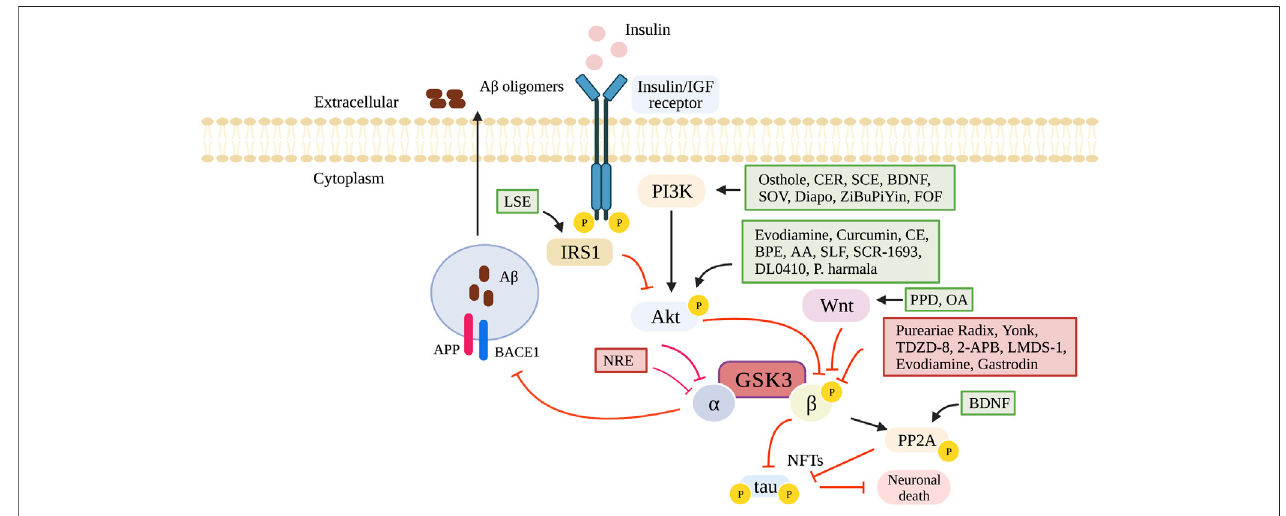
FIGURE 2 | GSK3 pathway and its modulating compounds. 2-APB, 2-Aminoethoxydiphenyl borate; AA, Asiatic acid; Akt, Protein kinase-B (serine/threonine kinase); APP, amyloid precursor protein; BACE1, beta-site APP cleaving enzyme 1; BDNF, brain-derived neurotrophic factor; BPE, bee pollen extract; CE, cinnamon extract; CER, sea cucumber cerebrosides; Diapo, diapocynin; FOF, fl avonoids of okra fruit; GSK3, glycogen synthase kinase-3; Insulin/IGF receptor, insulin-like growth factor 1 receptor; IRS1, insulin receptor substrate 1; NFTs, neuro fi brillary tangles; NRE, N.incisum extract; OA, Oleanolic acid; P, phosphorylation; P. harmala, Peganum harmala; PPD, 20(S)-protopanaxadiol; PI3K, phosphoinositide 3-kinase; PP2A, protein phosphatase 2 (alpha isoform); SCE, Schisandra chinensis extract; SLF, seed of litchi chinensis fraction; SOV, sodium orthovanodate; Yonk, Yonkena fi l. Created in BioRender.com.